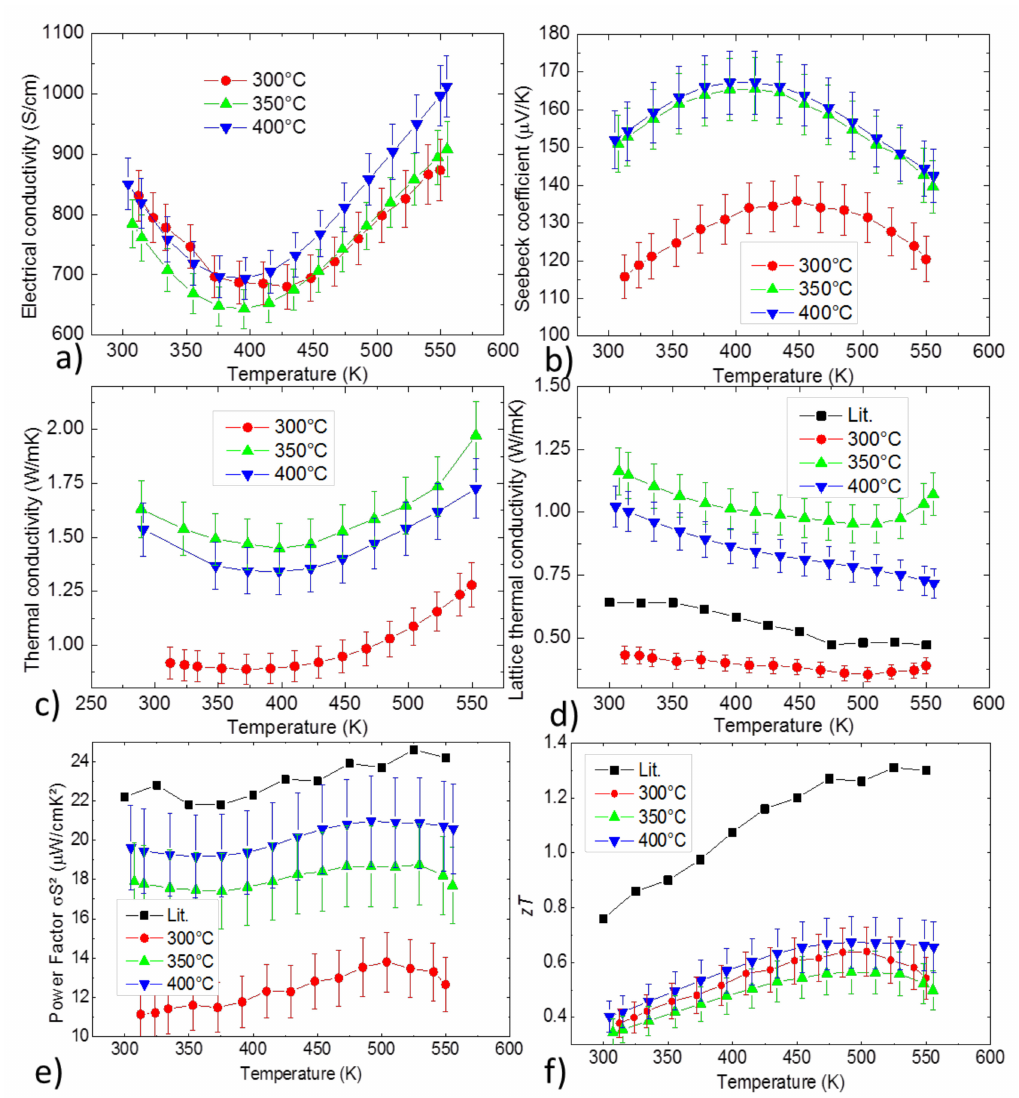
Figure 6. Temperature dependent ( a ) electrical conductivity, ( b ) Seebeck coe ffi cient, ( c ) thermal conductivity, ( d ) lattice thermal conductivity, ( e ) power factor and ( f ) figure of merit of samples from planetary ball milling with di ff erent sintering